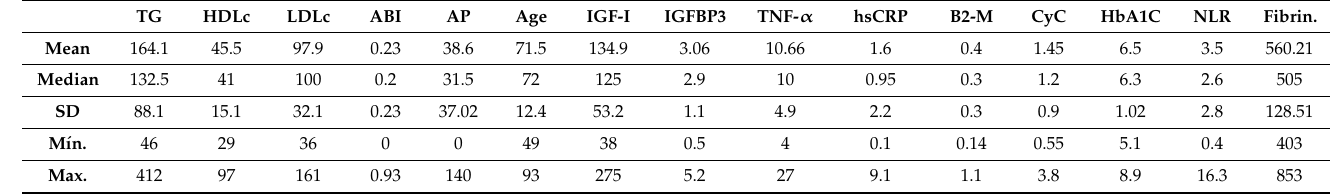
Table 2. Mean and median results of inflammatory parameters in CLTI patients from the GHAS trial. TG: Triglycerides; HDLc: High density lipoprotein cholesterol; LDLc: Low density lipoprotein cholesterol; ABI: Ankle–brachial index; AP: Ankle pressure; IGF-1: Insulin-like growth factor 1; IGFBP3: IGF-1 binding protein 3; TNF- α : Tumor necrosis factor alpha; hsCRP: C-reactive protein of high sensitivity; B2M: Beta-2 microglobulin; CyC: Cystatin C; HbA1C: Glycosylated